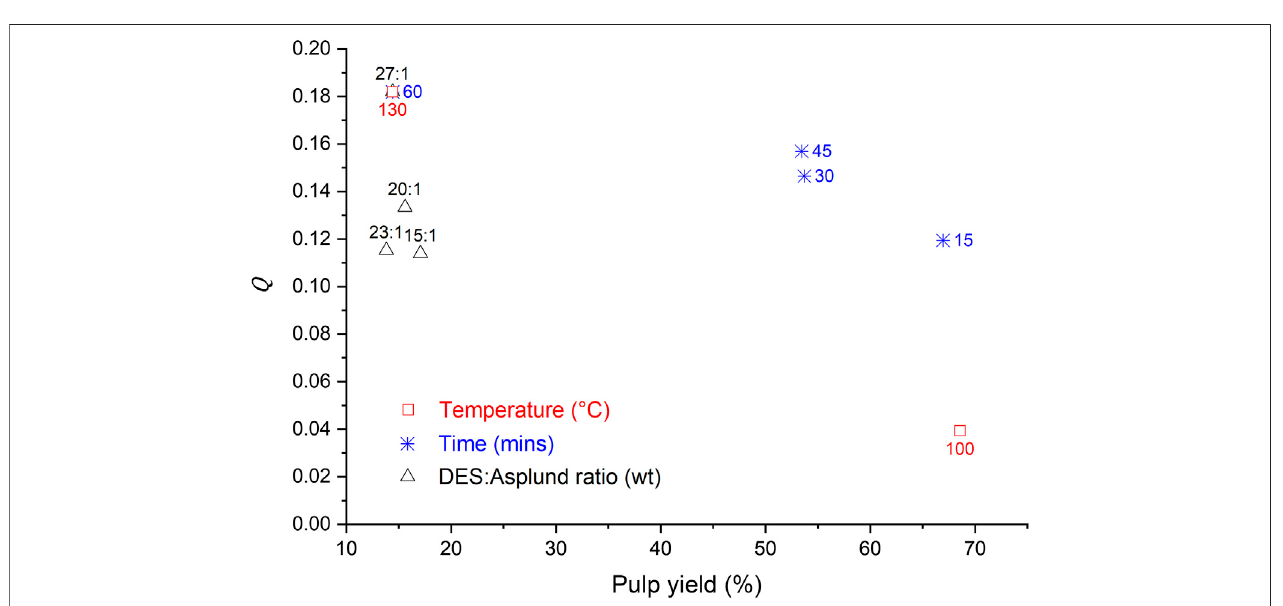
FIGURE 7 | The effect of the cooking temperature, the cooking time, and the L/W on the parameter Q in the DES-cooking of Asplund fi bers (at the RE setup).